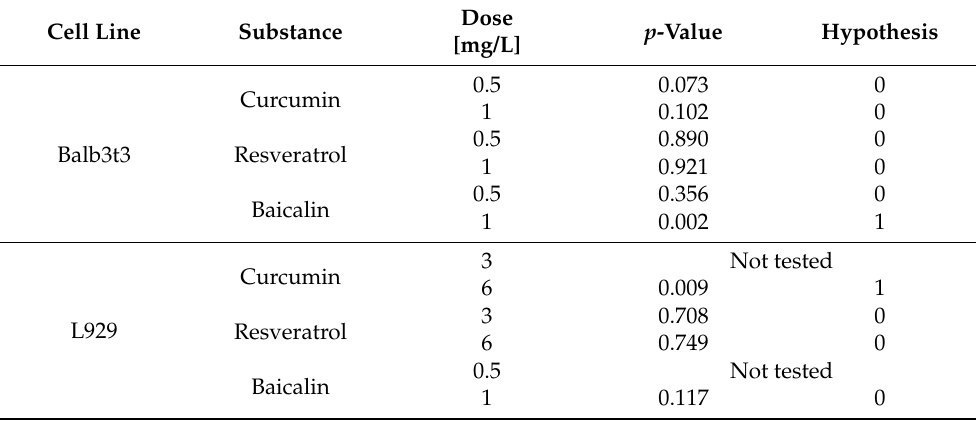
Table 2. Results of the t test. The hypothesis of equal means for samples and equal but unknown variances is: 0 = NOT rejected; 1 = rejected for significance level α = 0.05.